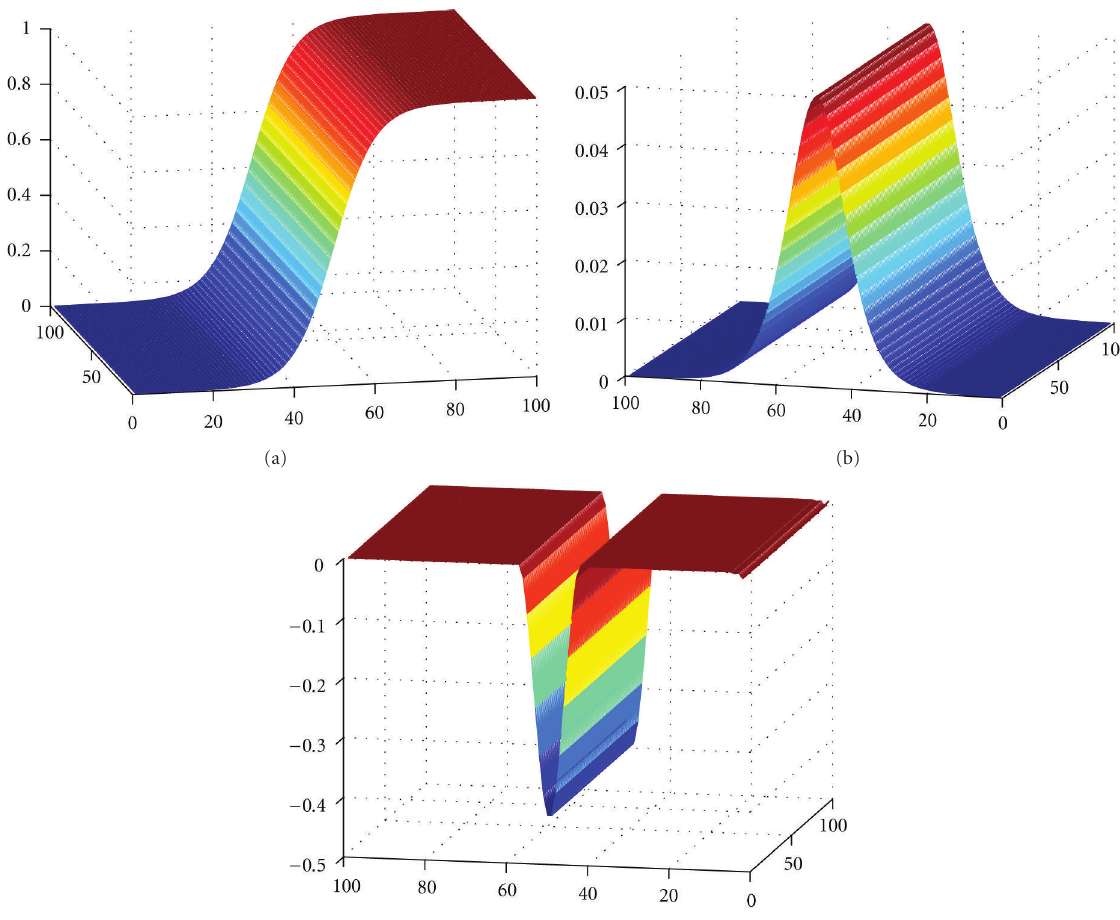
Figure 2: (a) Original image; (b) L 2 norm of the (standard) gradient of (a); (c) Topological gradient of